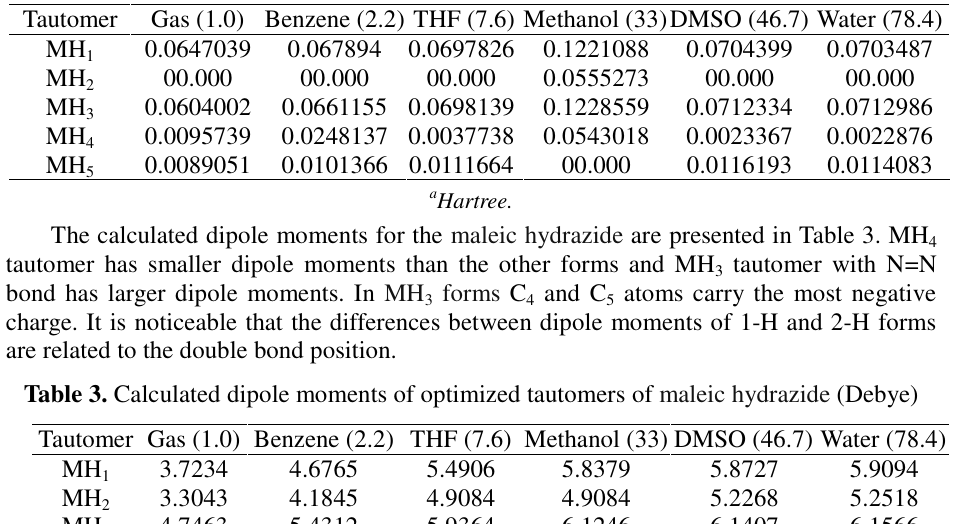
Figure 1. Tautomeric forms of maleic hydrazide and numbering of maleic hydrazide ring This indicates that due to the N=N, MH and MH are less stable in the gas phase. Table 2 3 2 shows deference stability between all the tautomers. Table 2. Energy a difference between the tautomers of maleic hydrazide